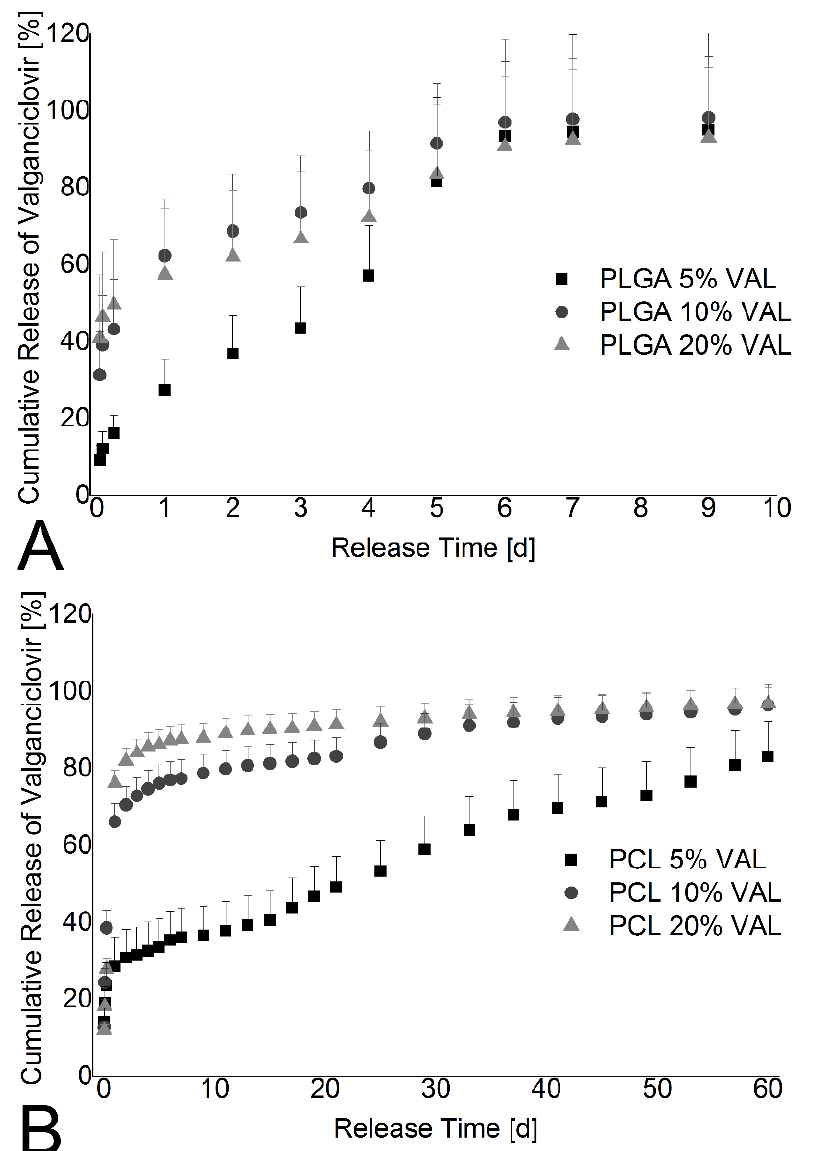
Figure 4. Cumulative release of valganciclovir in percent. The release is plotted in percent of total drug amount of each punchout versus the incubation time. The rectangles are the 5% valganciclovir films, the circle the 10% valganciclovir films, and the triangle the 20% valganciclovir films. Both PLGA and PCL films show significant burst releases in the first day. ( A ) Drug release profile of PLGA thin film over a time period of 10 days showing that drug release can be controlled, but with limited dependence on valganciclovir content. After six days, all three thin films have completely released their valganciclovir content; ( B ) Drug release profile of PCL thin film with a controlled release over a time period of 60 days showing a burst release dependent on the amount of valganciclovir added. The 5% pure PCL film shows a lower than usual amount of drug release (<50 µg/cm 2 ); however, a clear drug release profile can be